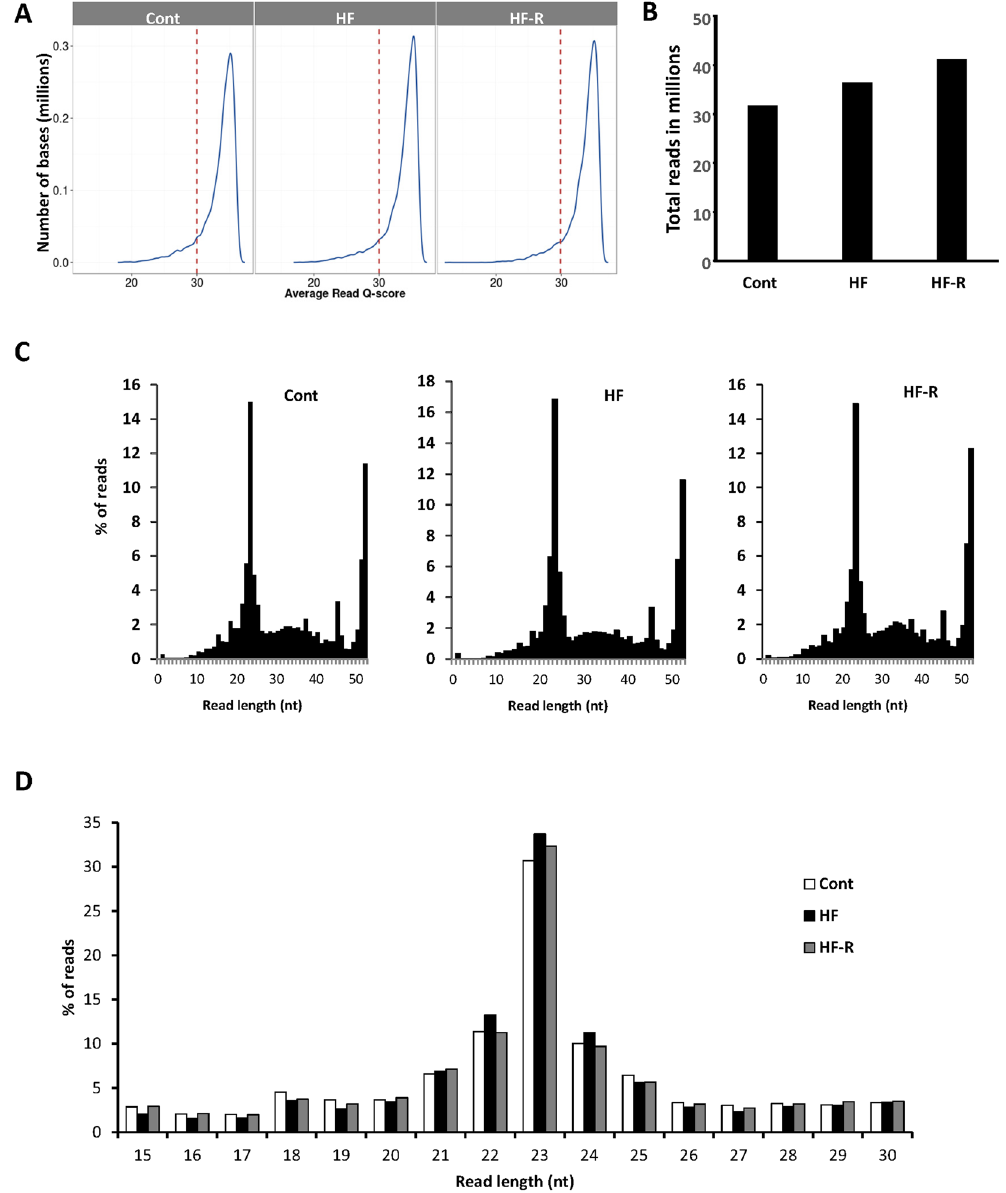
Figure 1. Overview of next generation deep sequencing (NGS) reads analysis. ( A ) The average Q-scores of the NGS sequencing data. ( B ) Total number of reads per group. ( C ) Overall nucleotide (nt) distribution. ( D ) Distribution of sequences between 15–30 nts representing miRNAs. Samples are pooled sheep left ventricular (LV) tissue from normal Controls (Cont, n = 4), Heart Failure (HF, n = 6) and Heart Failure-Recovery (HF-R, n =